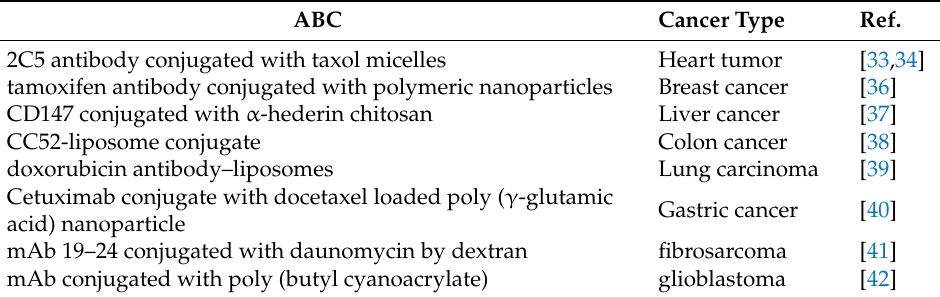
Table 2. Examples of applications of ABC in oncology.